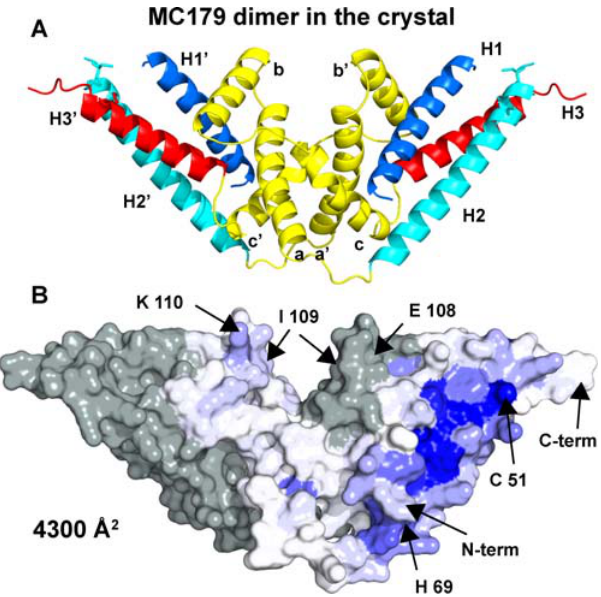
Figure 8. MC179 forms a dimer in the crystal. (A) Contact between the molecules is primarily between the helices (yellow) that connect the H2 and H3 helices and between the H1 (dark blue) to H3 (red) sides of the three-helix bundles. (B) The molecular surface of the crystalline dimer shows the intertwining of the two molecules in a ‘‘handshake’’ manner. One molecule (at right) is colored by sequence conservation in a ramp of blue to white as in Figure 3, and the other molecule (at left) is colored gray for contrast. The total buried solvent- accessible surface area is 4300 A˚ 2 . The surface complementarity is 0.70 [46] and 55 residues (220 atoms) from each molecule take part in the interaction. The two MC179 molecules are related by a crystallographic two-fold symmetry axis. The locations of several residues are